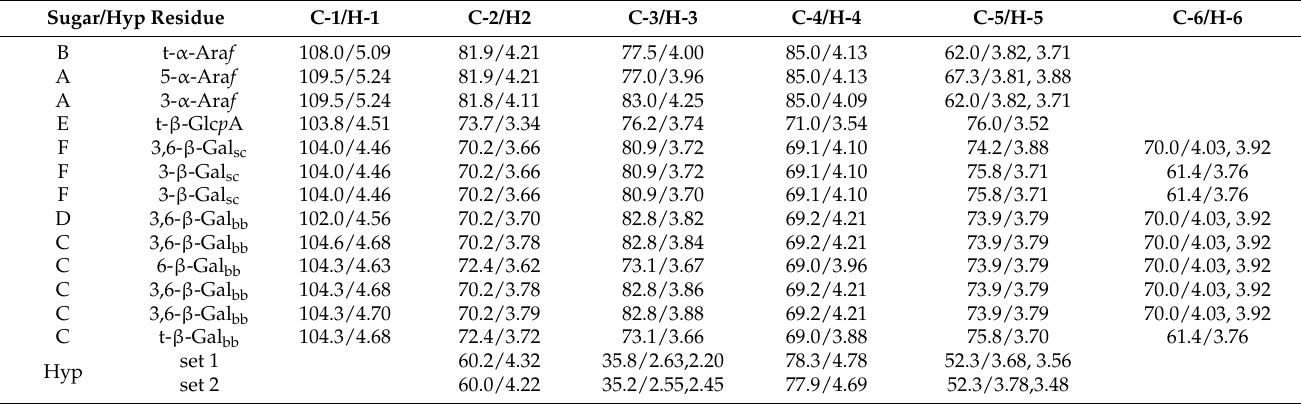
Table 2. Summary of 13 C and 1 H chemical shifts for AtSPHP-1 assigned from Figure 2. Gal bb : Gal p on galactan backbone; Gal sc : Gal p on AG side